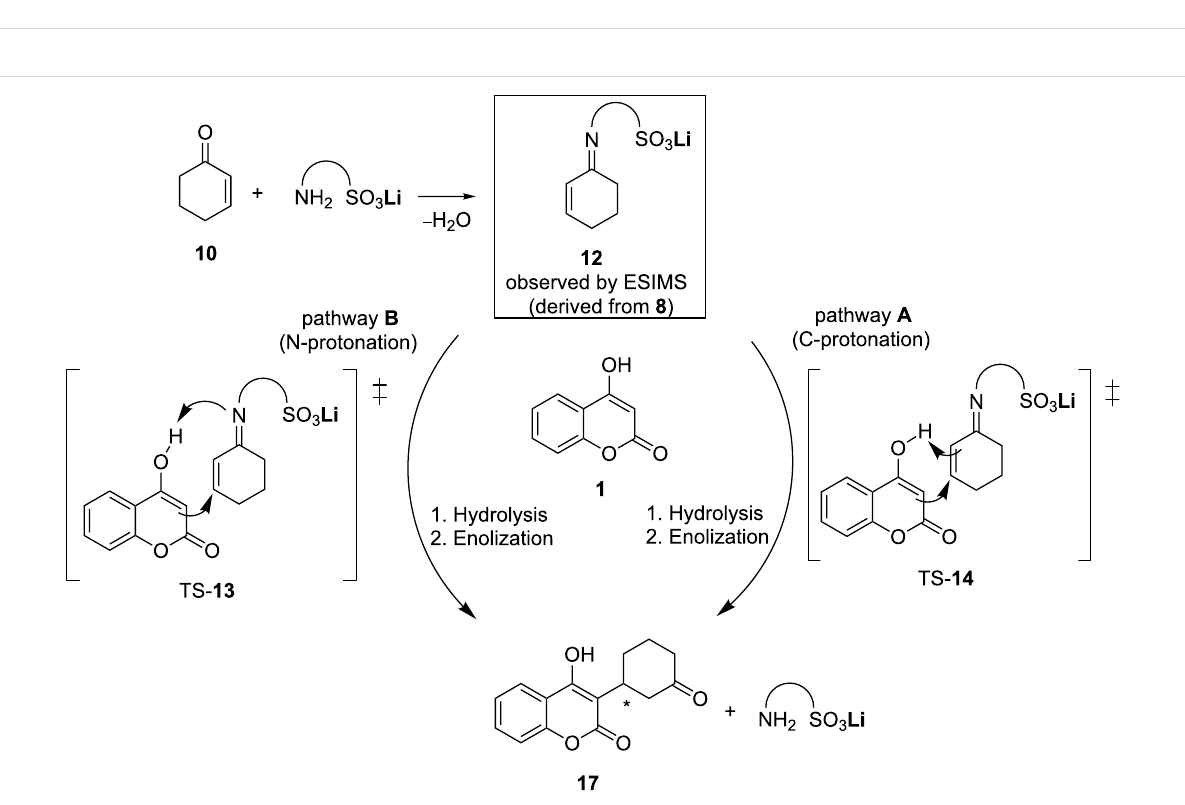
Scheme 4: Computationally analyzed pathways A (C-protonation), and B (N-protonation), arising from the addition of 4-hydroxycoumarin to cyclo-